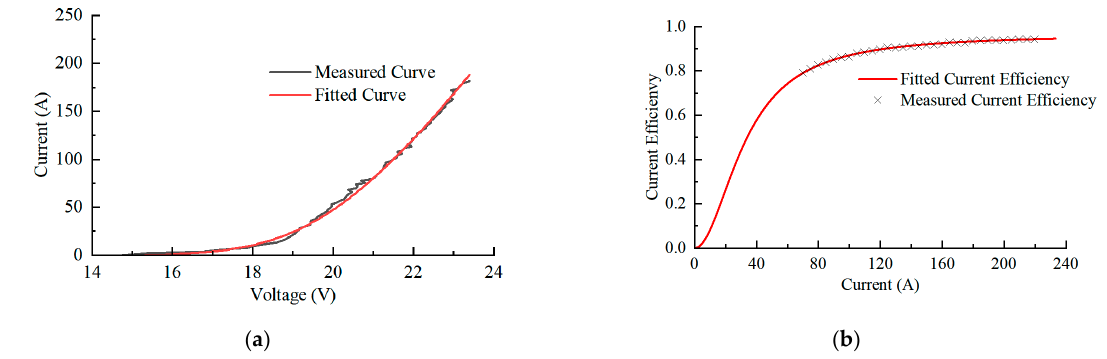
Figure 4. Electrical and current efficiency characteristics of the electrolyzer. ( a ) Voltametric curve of